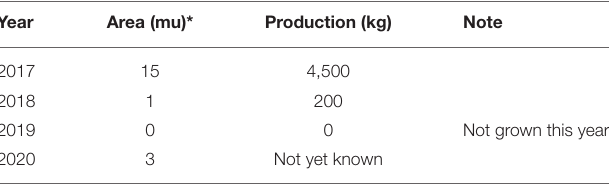
TABLE 7 | The area and production of